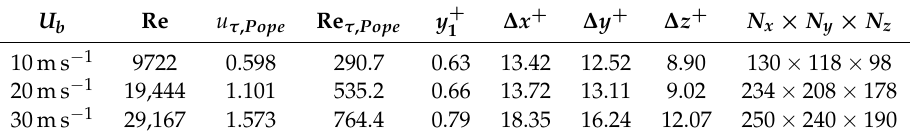
Table 1. Simulation parameters for inert large eddy simulations